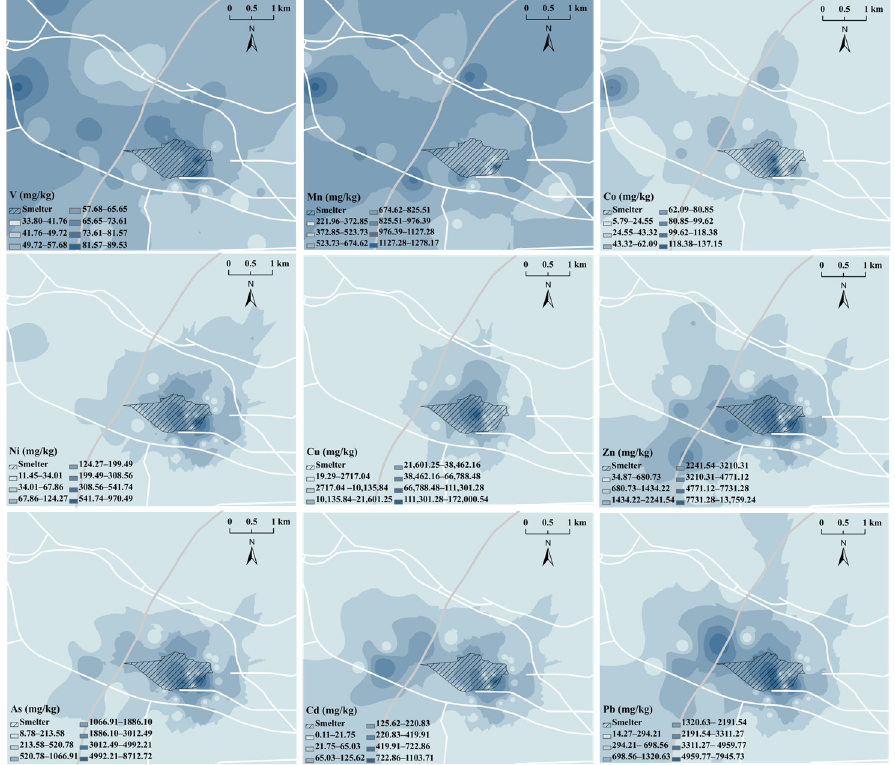
Figure 3. Spatial distribution of heavy metals in soils of the surrounding area and non-ferrous metal smelting plant (NMSP).